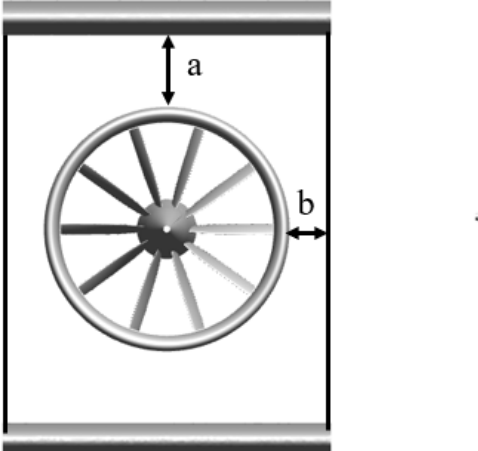
Figure 15. The three geometric parameters (a, b and c) that determine the relative position between the ducted fan and wings.